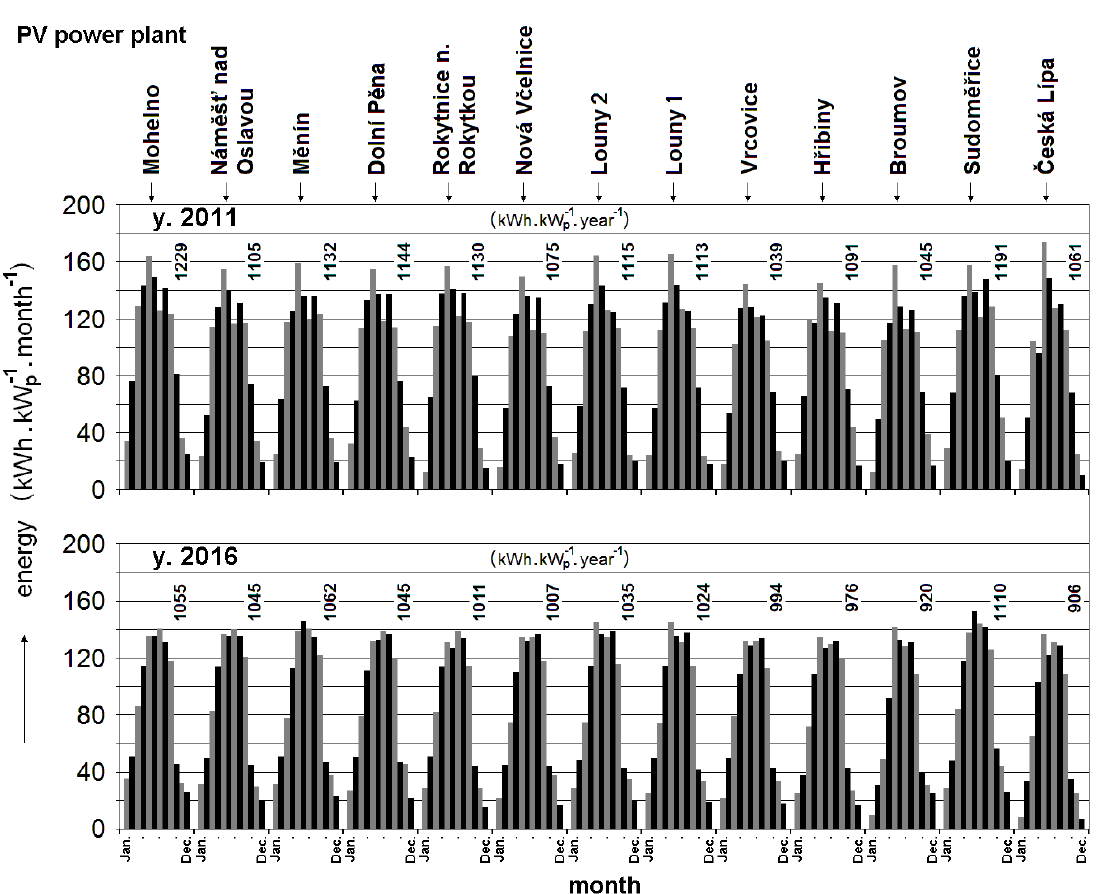
Figure 7. An example of the data evaluation from the selected PV power plants during the years 2011 and 2016; the graph of generated electrical energy for each month.